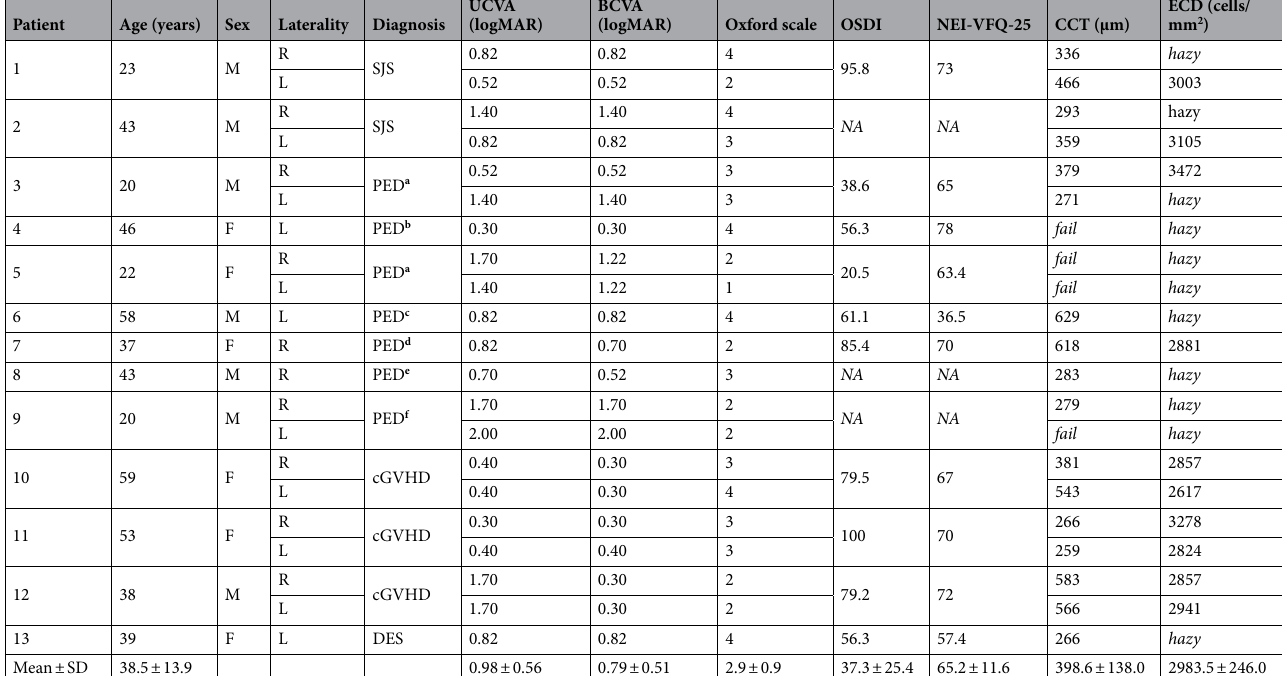
Table 1. General demographics of patients ultimately enrolled at screening. a Aniridia associated limbal stem cell deficiency, b Exposure keratopathy with neurotrophic keratitis, c Exposure keratopathy, d Exposure keratopathy associated with incomplete eyelid closure after upper eyelid blepharoplasty, e Limbal stem cell deficiency after conjunctival squamous cell carcinoma in situ excisional operation with cryotherapy and topical interferon α2b application, f Near total limbal stem cell deficiency due to contact lenses. M: male, F: female, R: right, L: left, UCVA: uncorrected visual acuity, logMAR: log of minimal angle of resolution, BCVA: best- corrected visual acuity, SJS: Stevens–Johnsons Syndrome, PED: persistent epithelial defect, cGVHD: chronic graft-versus-host-disease, OSDI: ocular surface disease index, NEI-VFQ-25: National Eye Institute 25-Item Visual Function